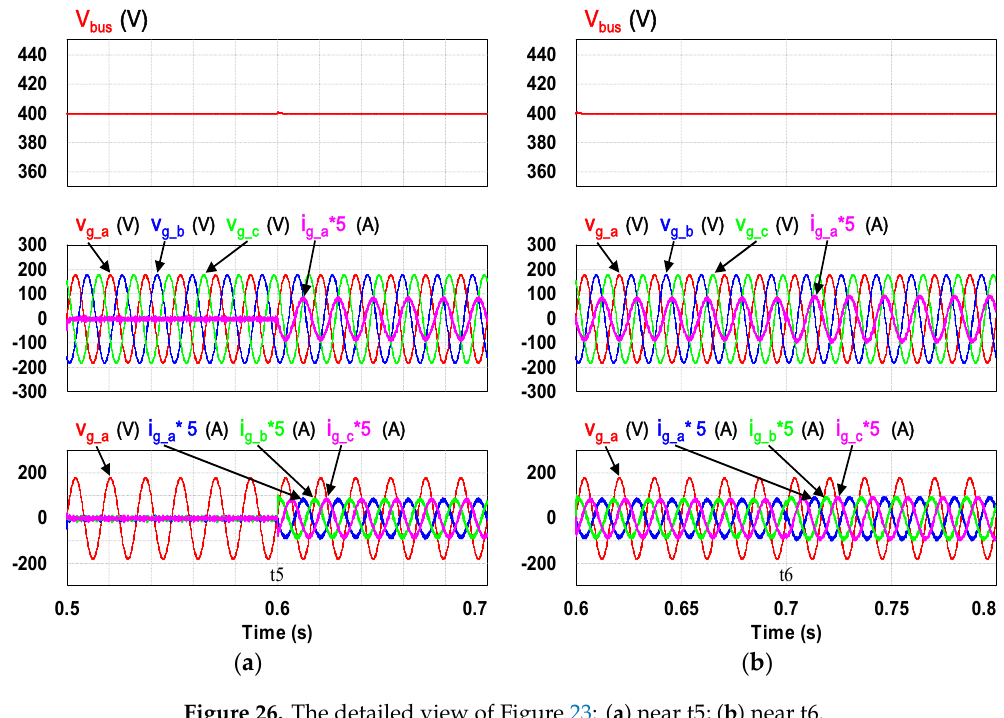
Figure 26. The detailed view of Figure 23: ( a ) near t5; ( b ) near t6.